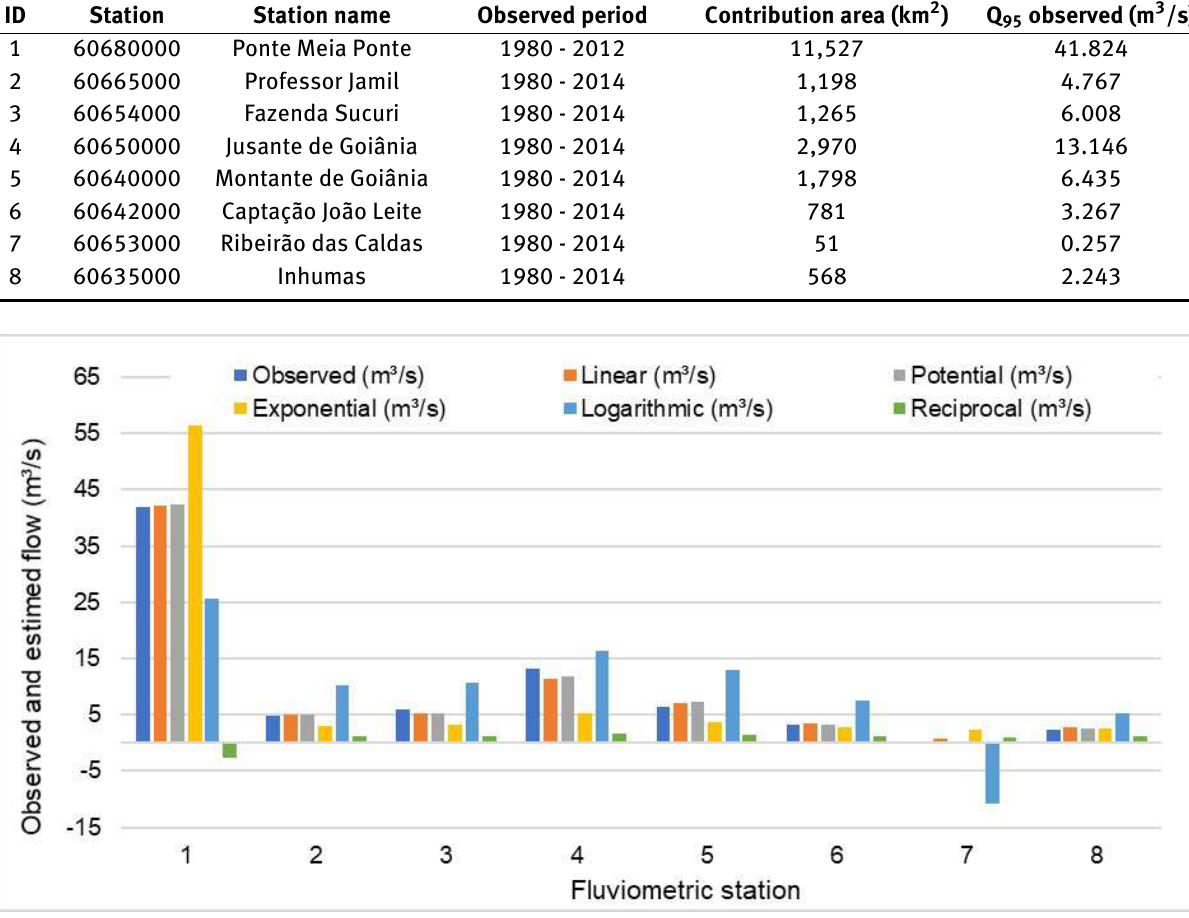
Figure 2: Observed flows and flows estimed by the studied models.